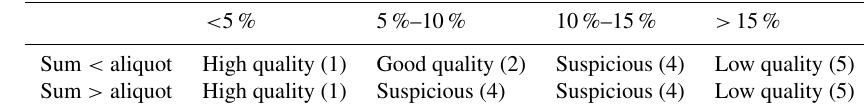
Table 4. Quality flags set if the sum of their components differed from the biomass aliquot.